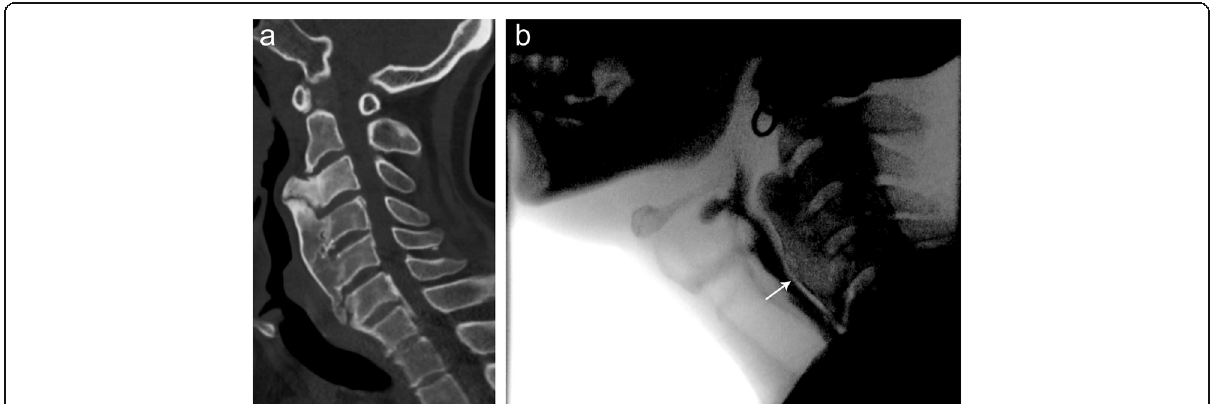
Fig. 17 Diffuse idiopathic skeletal hyperostosis. Sagittal ( a ) noncontrast CT image of the cervical spine demonstrating large anteriorly flowing osteophytes extending from the C3 – C7 levels without significant disc height loss consistent with the diagnosis of diffuse idiopathic skeletal hyperostosis (DISH). Lateral ( b ) fluoroscopy during a pharyngogram demonstrates posterior compression (arrow) of the cervical esophagus during